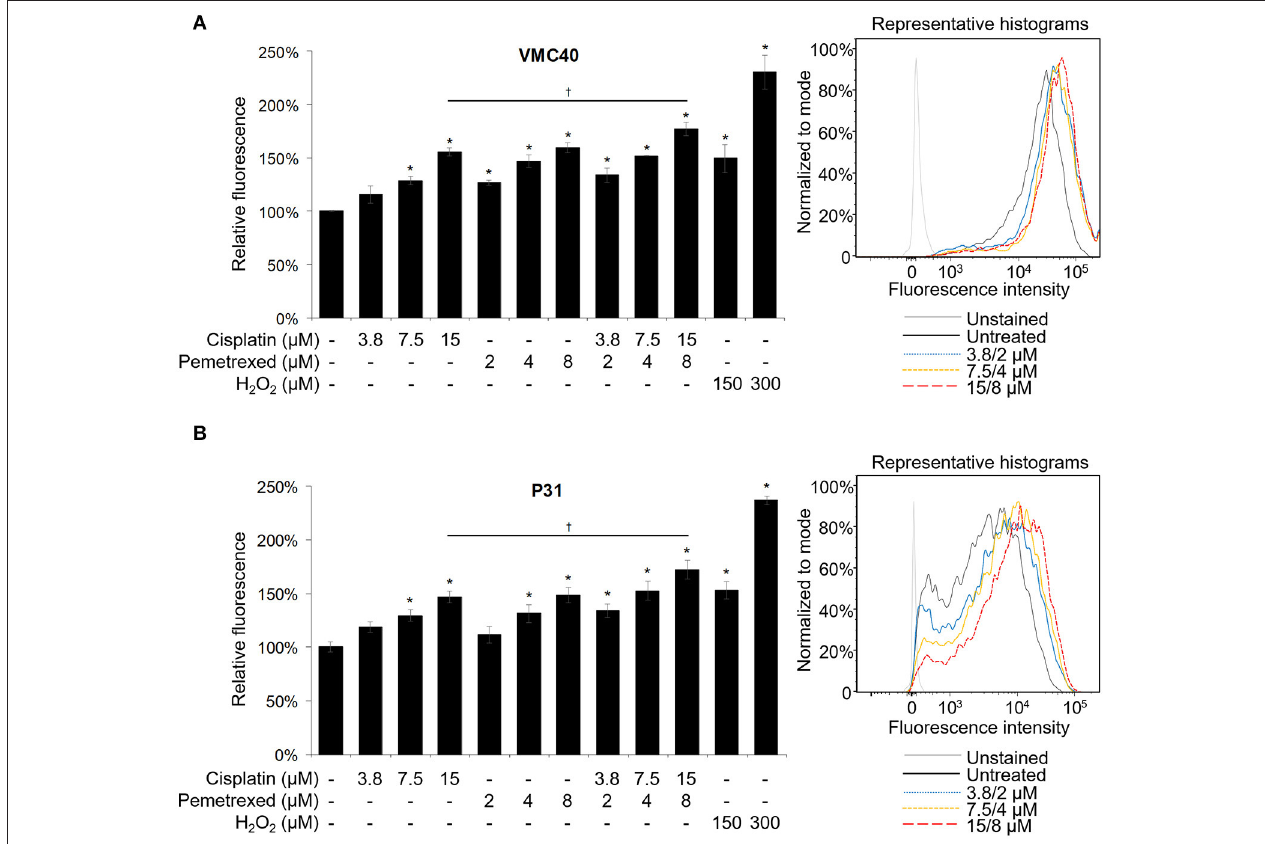
FIGURE 2 | Cisplatin and pemetrexed induce ROS generation. The CM-H 2 DCFDA ROS indicator was preloaded into (A) VMC40 and (B) P31 cell lines, followed by 30m of cisplatin and pemetrexed treatment. Fluorescent signal was detected by flow cytometry, and area-under-curve values were compared to untreated samples as percentages. Representative histograms of combined cisplatin and pemetrexed concentrations on right . Error bars represent ± SEM of three experiments. * and † denote p < 0.05 via t -test for value compared to untreated control and to drug combination, respectively.